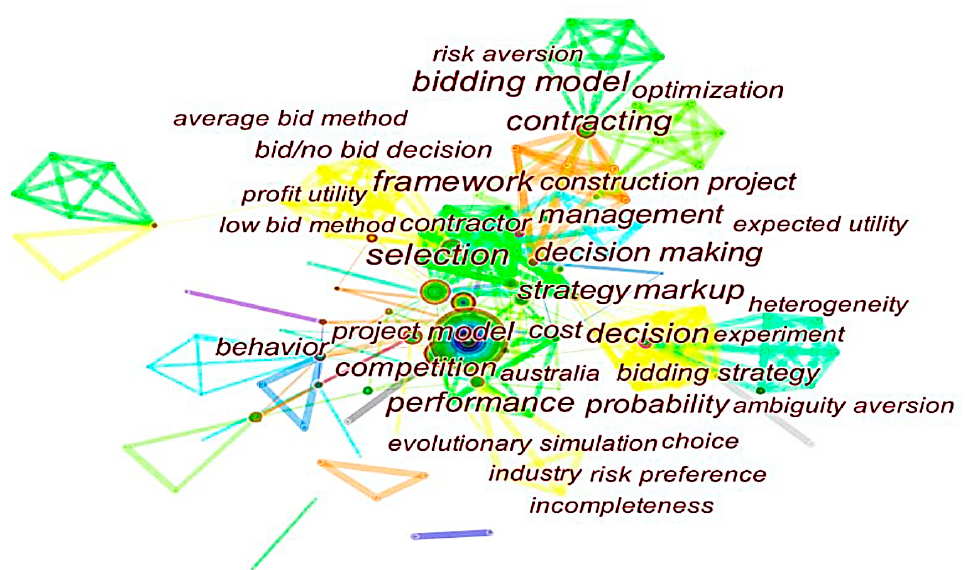
Figure 2. Keyword co-occurrence network for construction bidding.